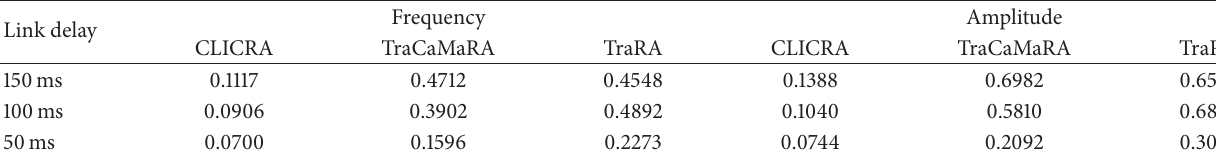
Table 8: Switch frequency and amplitude for receive window 60 Kbytes.